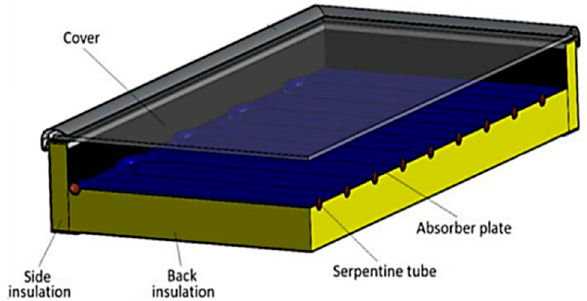
Figure 2. The main components of an FPSC [30].